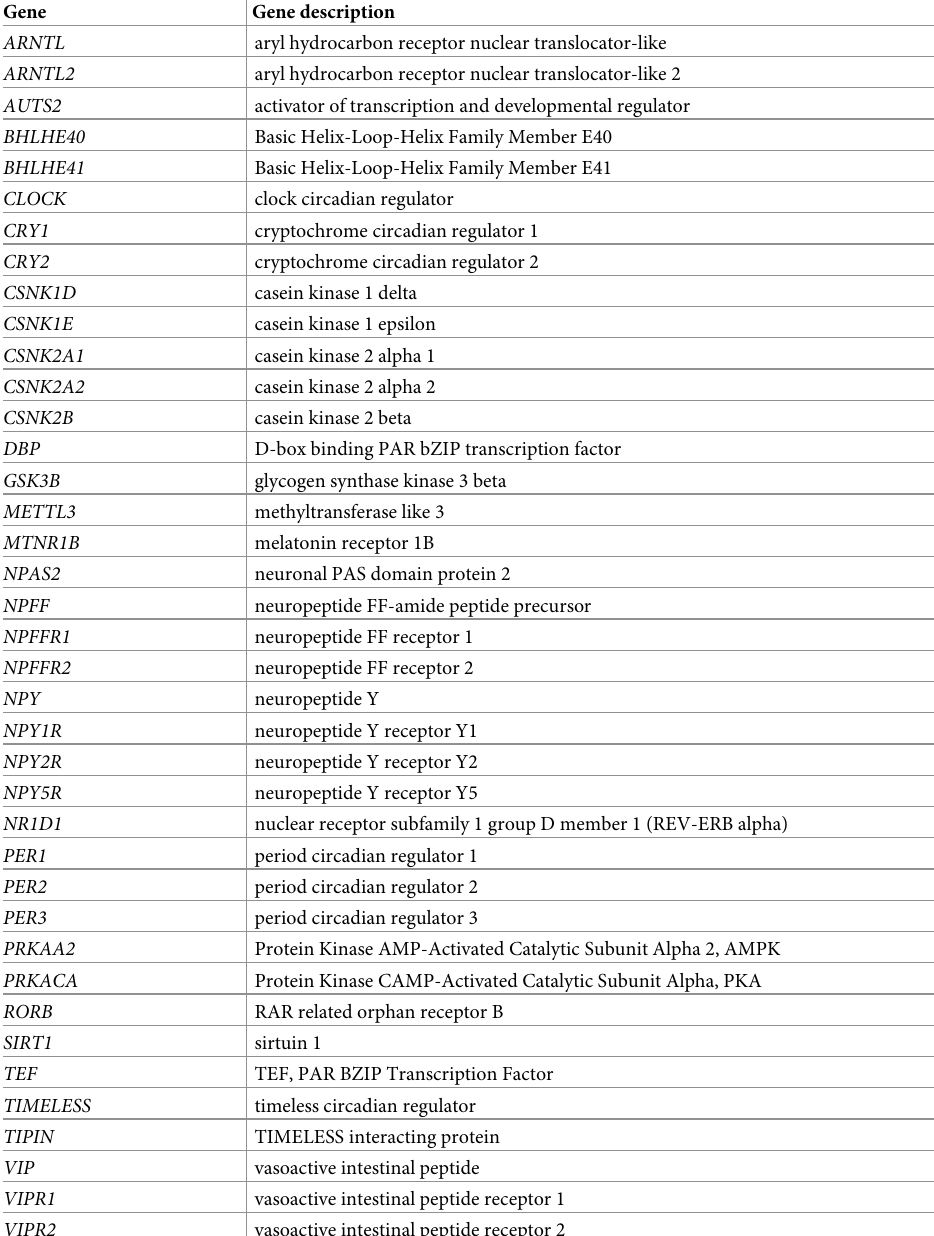
Table 1. Selected circadian rhythm-related